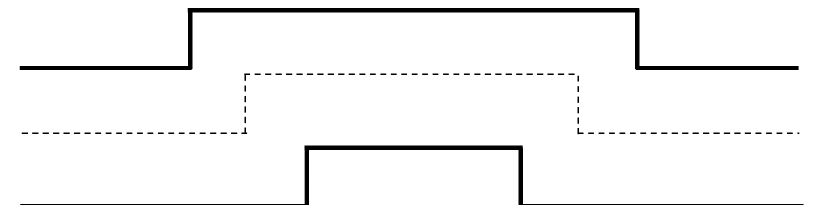
Figure 10. Road diagram of the double shift line condition.